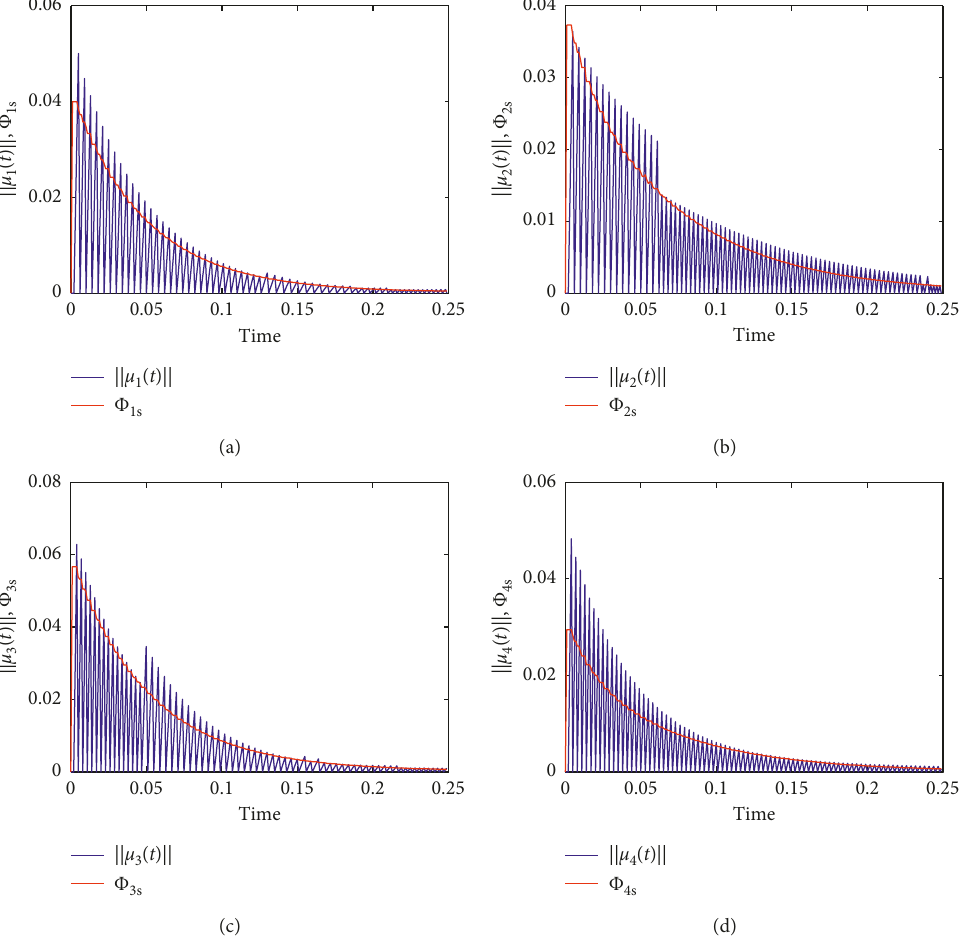
t and the thresholds k ( )